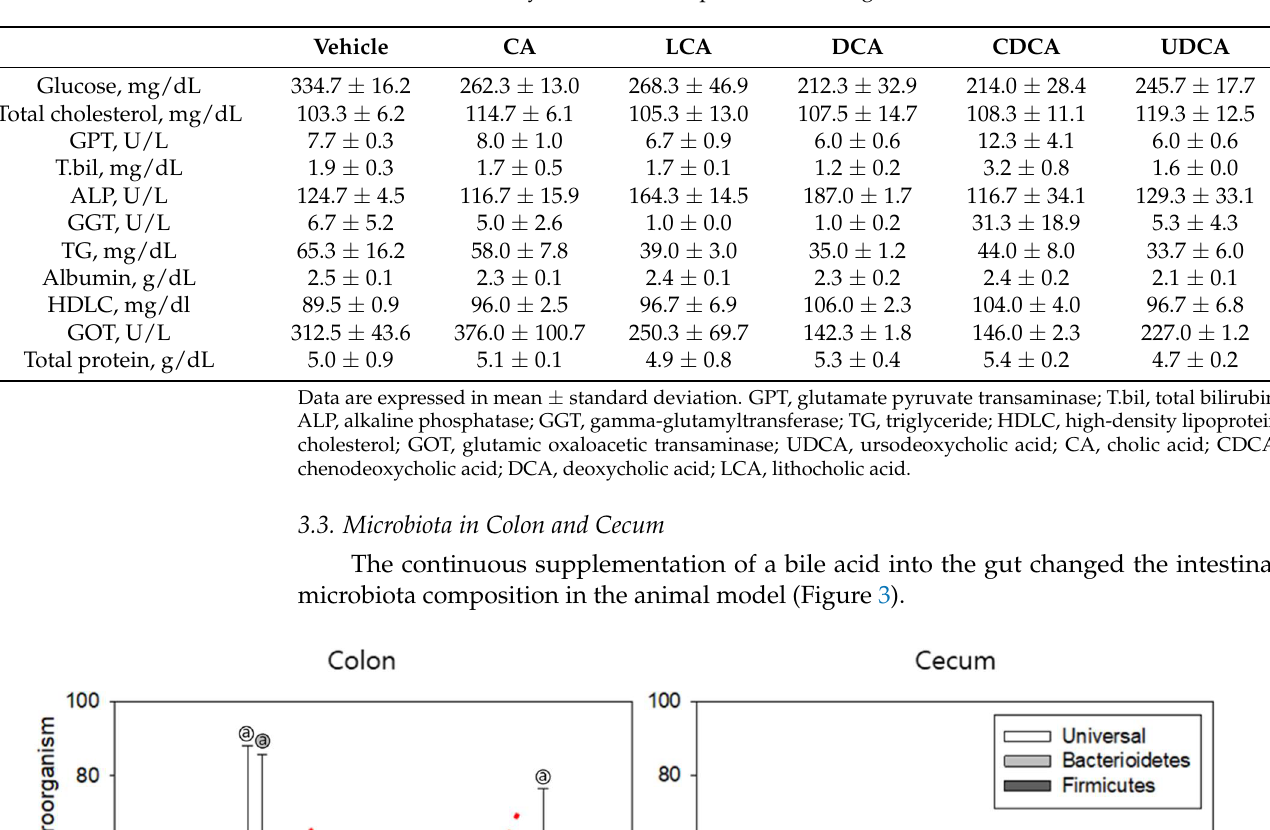
Table 1. Results of analysis of blood samples taken during sacrifice.